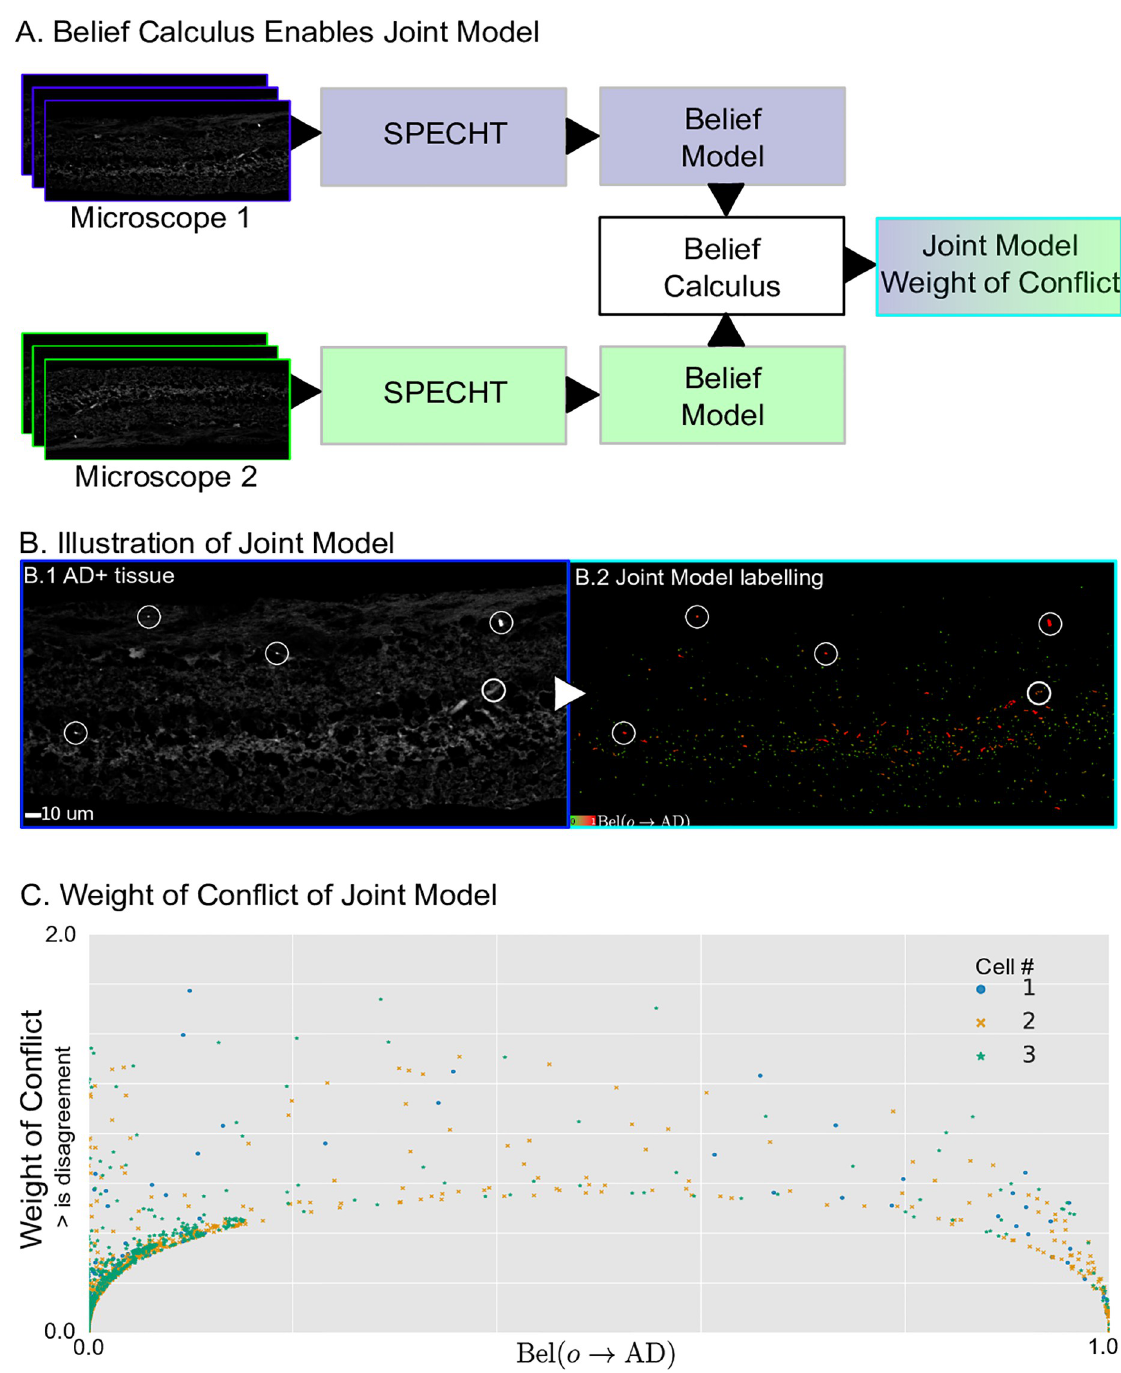
Fig 10. Results on Alzheimer data. A: Belief calculus enables the combination of models learned data originating from different microscopes. B: We visualize how the joint model operates on a single image of retinal tissue stained for amyloid- β , sourced from an AD+ positive patient. Object marked in red express a high belief in being AD+ specific. C: We offer the end user a per-object expression of the conflict between the 2 models that create the joint model. An increased weight of conflict (Y-axis) indicates the models disagree on the labelling for a specific object. We illustrate the visualization here for 3 AD+ images. Observe that for objects where both models are uncertain ( * .5) their minimal conflict is higher than it is for objects that have a higher support for being either AD+ specific or healthy.